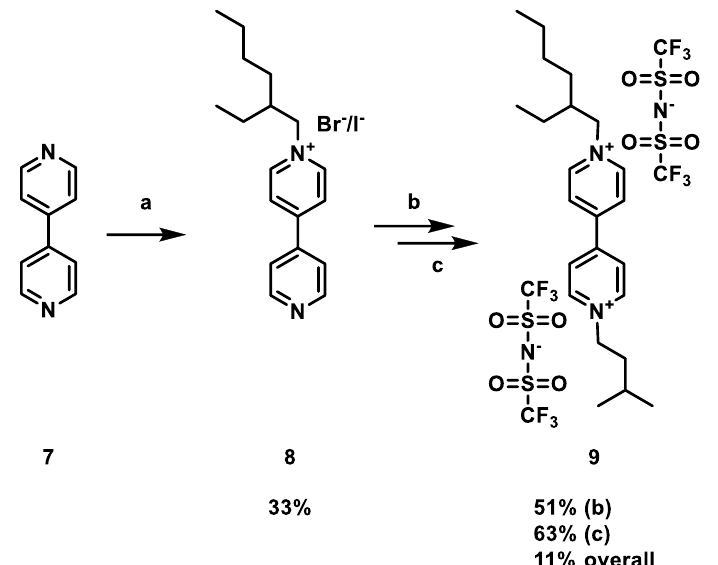
Scheme 3. Schematic representation of the synthesis of a RAIL based on 4,4 ′ -bipyridine. ( a ) 2- Ethylhexyl bromide, potassium iodide, acetonitrile, reflux, 24 h; ( b ) isopentylbromide, acetonitrile,